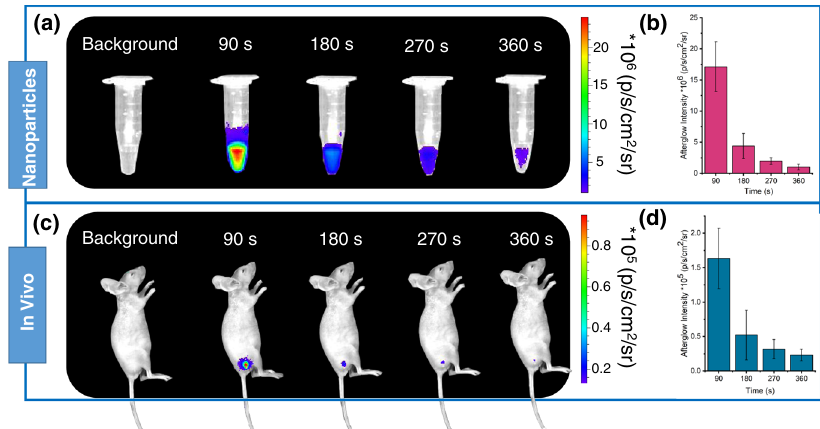
Fig. 6 In vivo afterglow imaging. a Afterglow images after UV irradiation (25.5 mW/cm 2 ) of TPM (47.5 μ g/mL) for 60 s. b Quanti fi cation of the afterglow intensities of the sample in a . c In vivo afterglow imaging of living mice after subcutaneous injection (100 µ L) of TPM (47.5 μ g/mL). Afterglow images were acquired after UV irradiation of mice for 60 s. d Quanti fi cation of the afterglow intensities of the injection areas in c . All bars represent mean ± SD ( n =